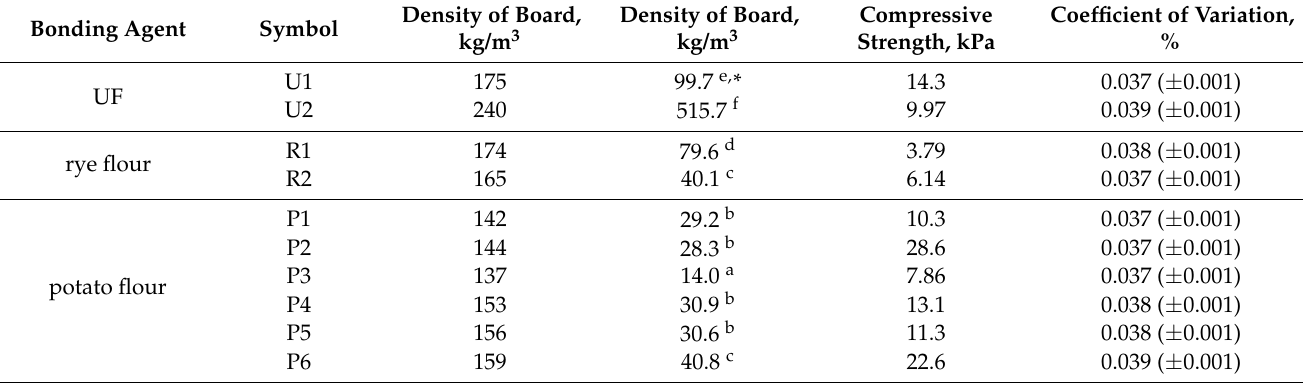
Table 2. Effect of manufacturing parameters on the compressive strength of manufactured boards—fiber moisture 7.2%.